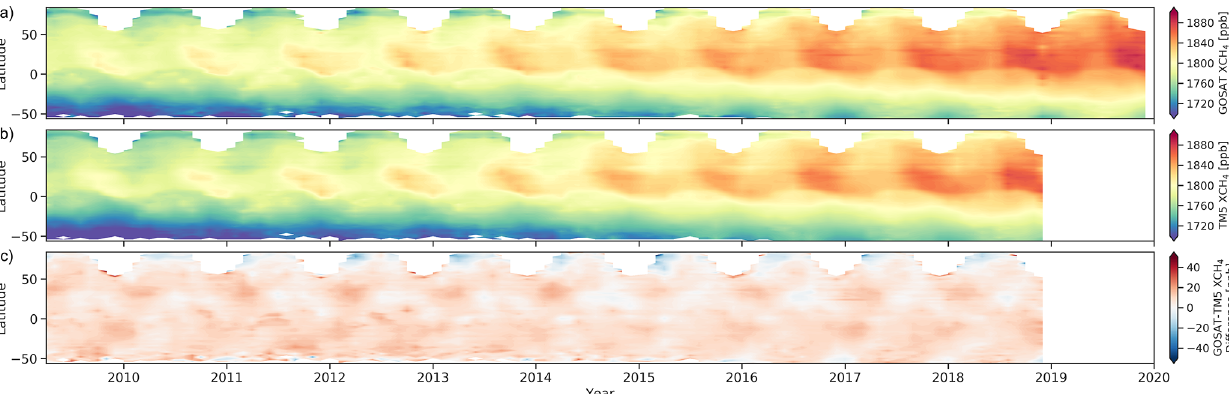
Figure 11. Hovmöller (latitude vs. time) plot of the GOSAT Proxy XCH 4 (a) , TM5 model XCH 4 (b) and GOSAT–TM5 difference (c) . The model data have been sampled at the time and location of the GOSAT observation and have had the sounding-specific GOSAT averaging kernel applied.